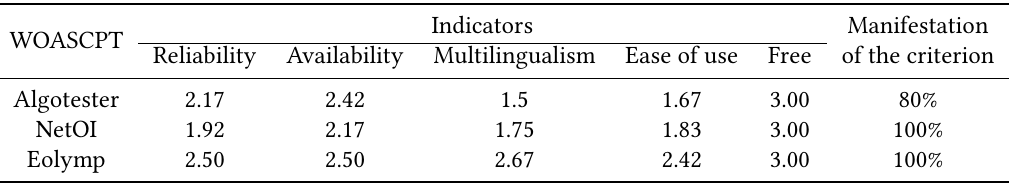
Table 3 Design criterion for web-oriented automated systems for checking programming tasks and its indicators.